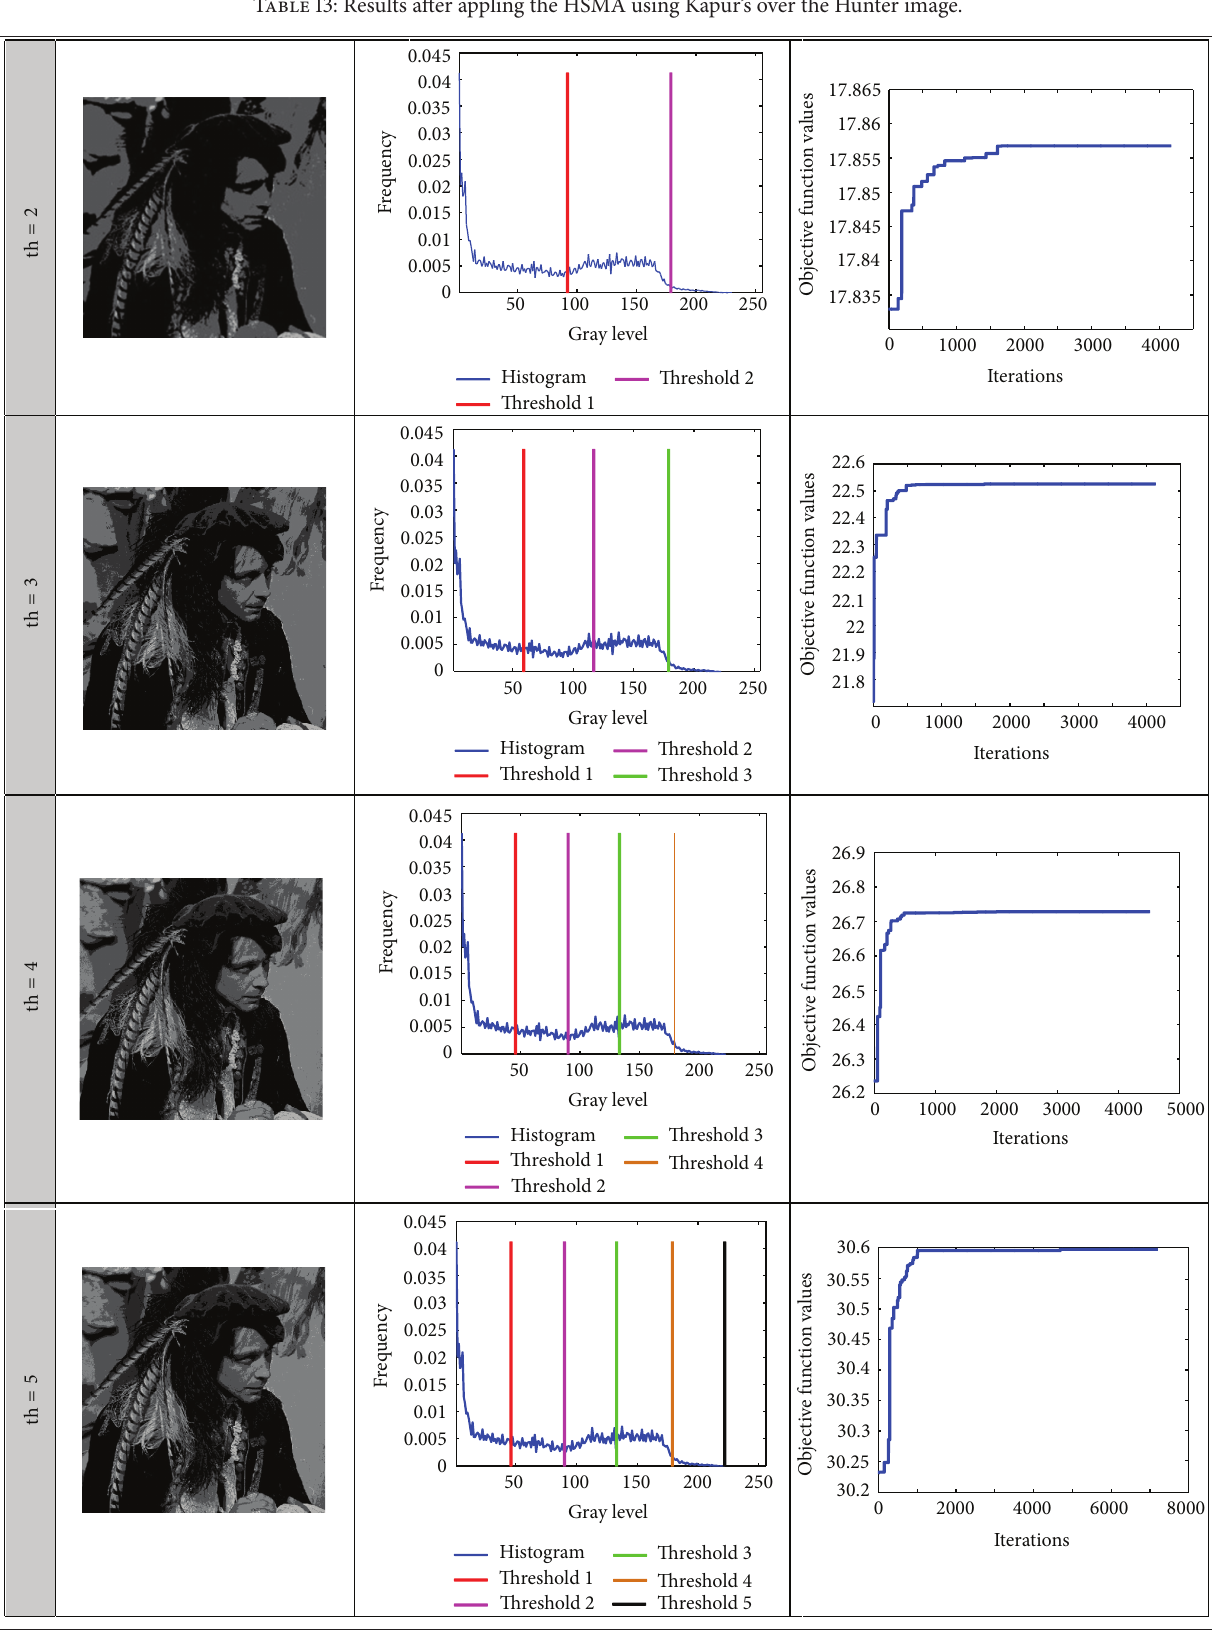
Table 13: Results after appling the HSMA using Kapur’s over the Hunter